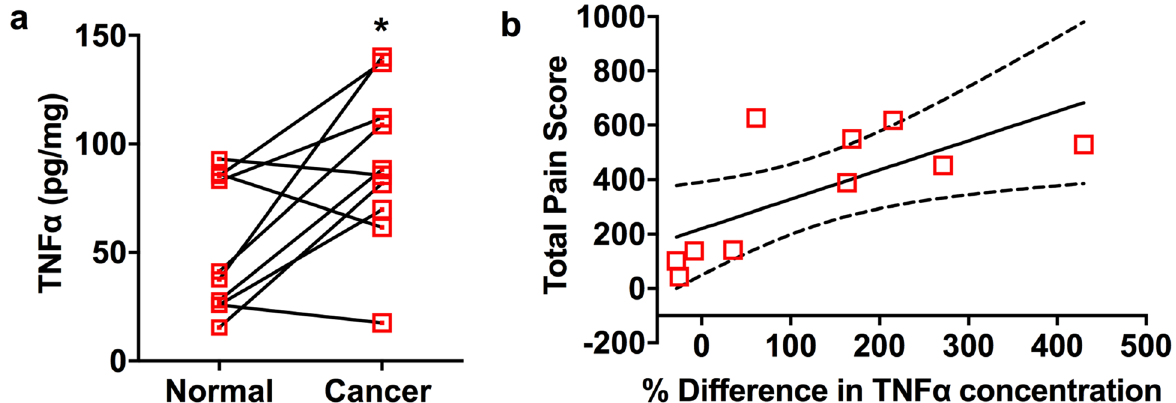
Figure 1. TNFα is correlated with human oral cancer pain scores. ( a ) TNFα protein concentration is higher in cancer tissues compared to anatomically matched contralateral healthy tissues from the same patient (n = 10, * P < 0.05, paired t-test). ( b ) Patients were asked to answer the Oral Cancer Pain Questionnaire before surgery. The mean pain score from patients correlated positively with percentage change in TNFα concentration between cancer and matched contralateral normal tissues ( r = 0.7, P <